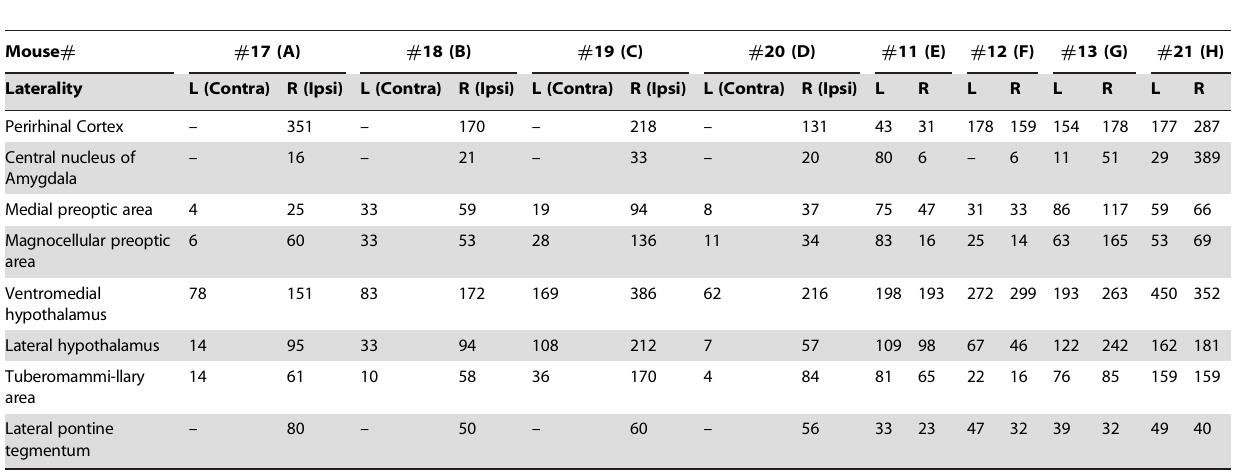
Table 2. Number of reterogradely labeled neurons in different brain areas following injection of CTb into the ventrolateral periaquaductal gray area